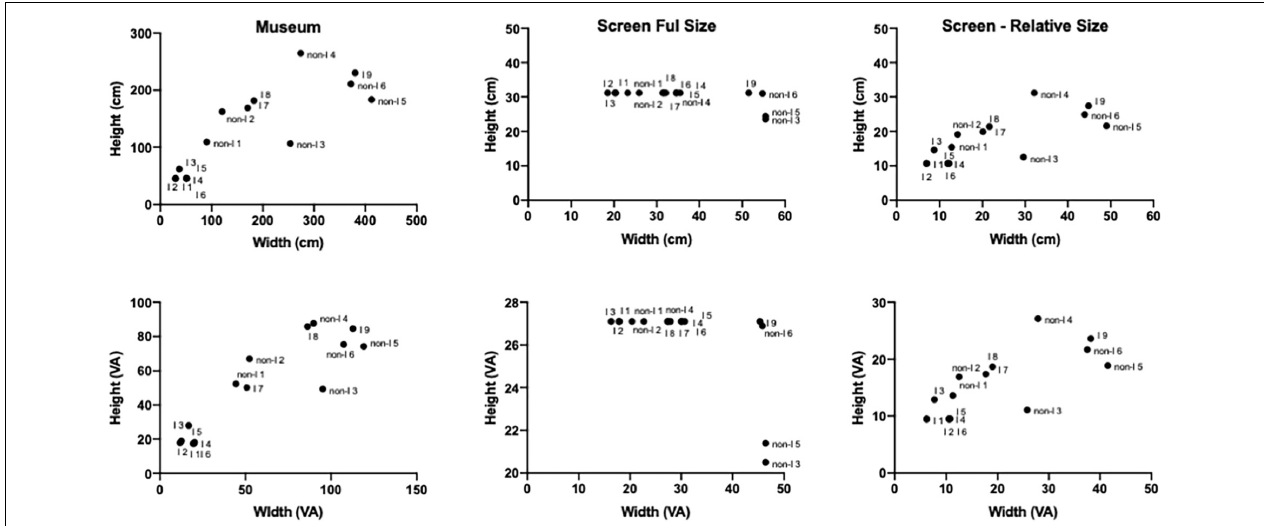
FIGURE 5 | Scatterplots of width and height dimensions in cm (top row) and degrees of visual angle (bottom row) of paintings in all three conditions. The visual angles in the museum condition were calculated based on the average mean distance estimates for every